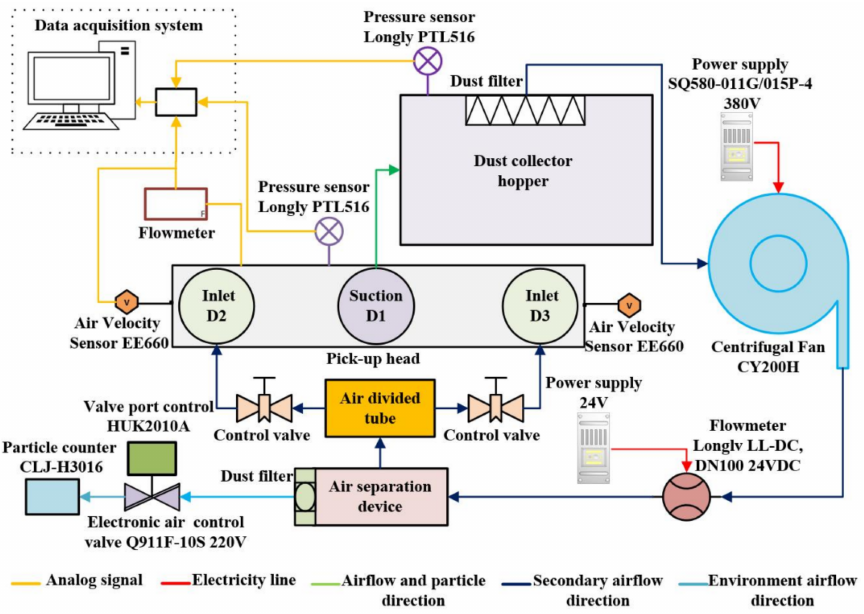
Figure 1. The structure of the regenerative air vacuum road cleaning dust control